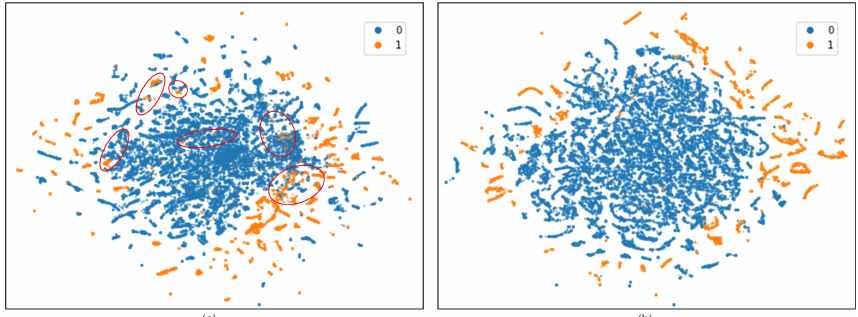
Figure 7. Study the performance of SSAE according to varying proportion of labeled samples, latent size and experiment round. ( a ) Capability of semi-supervised learning against NTL. ( b ) Studying the effect of latent size to SSAE. ( c ) F1 score and AUC score on each round of experiment.